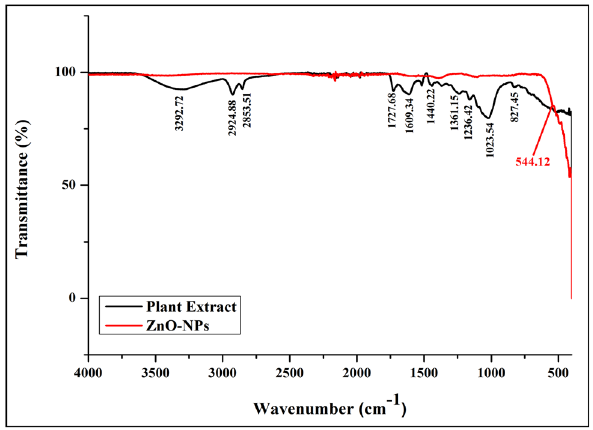
Figure 3: FT - IR spectrum of phyto - fabricated ZnO NPs from S. acuta .